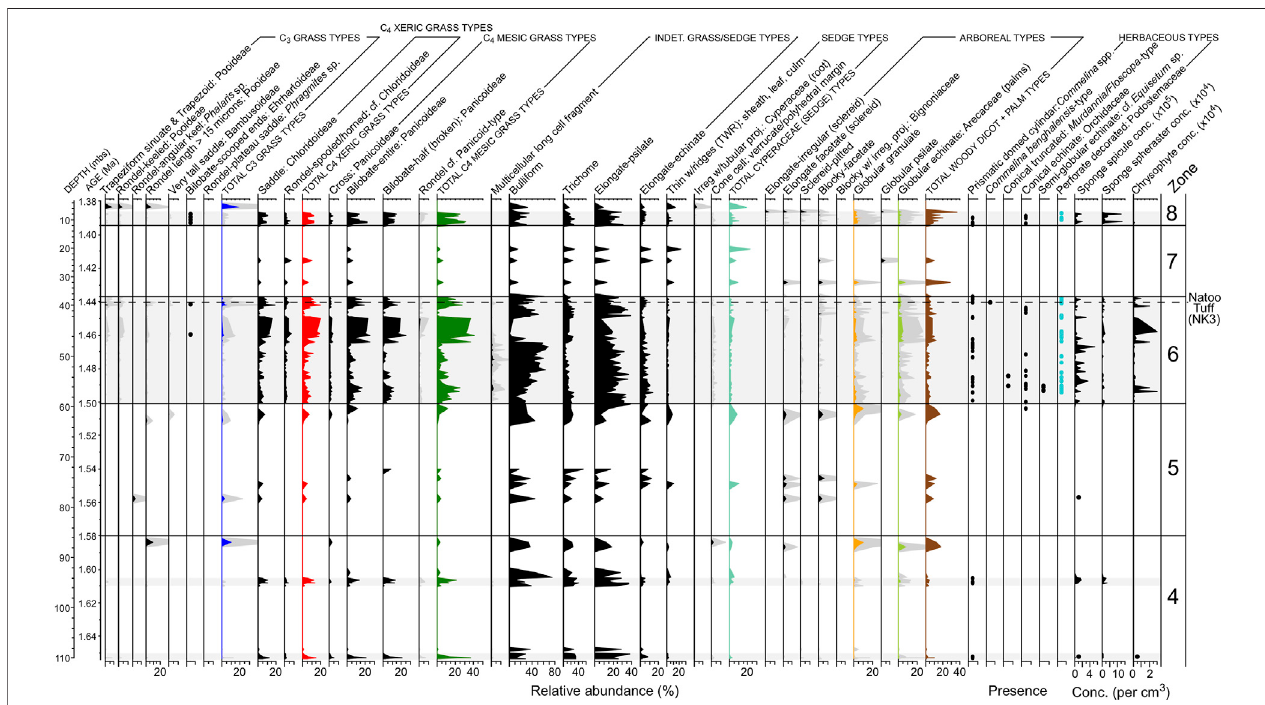
FIGURE7| Phytolithrelativeabundanceforselectedmorphotypes between1.66and1.38 Ma.Somemorphotypesincludeagray shaded5xexaggeration.Black dots denote presence, but at values too low to show up on diagram. Horizontal gray shaded bars denote intervals with good phytolith preservation. Unshaded (white) intervals are periods with poor phytolith preservation and partial or complete loss of the phytolith record. The vertical dashed line marks the position of the Natoo Tuff in WTK13, which is a core-to-outcrop tie point for the Nariokotome Boy ( Homo erectus/ergaster ) site (NK3).